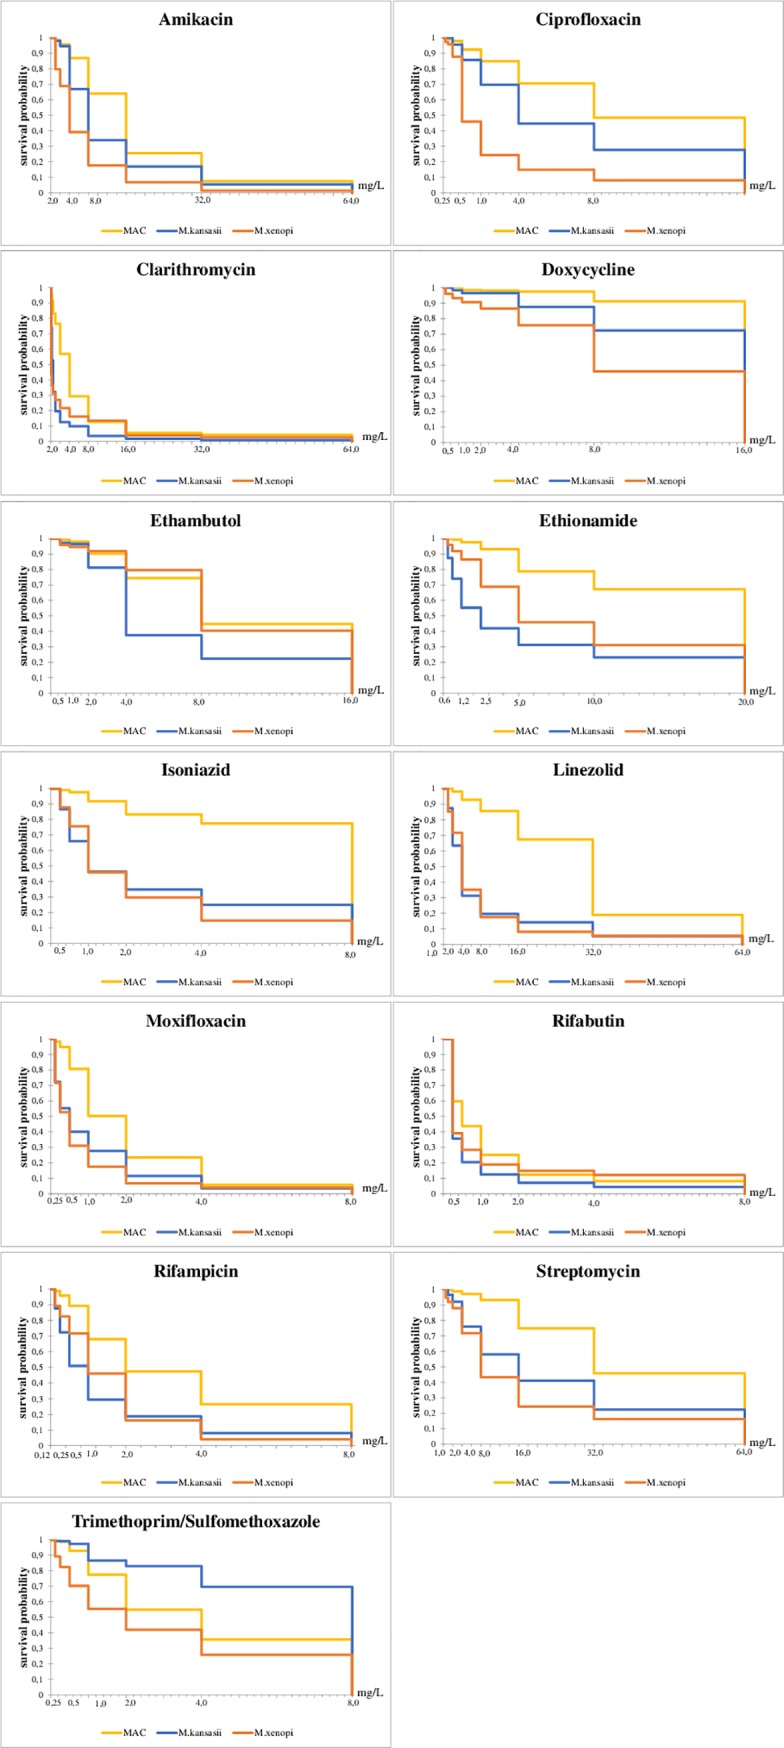
The comparison of Kaplan-Meier survival curves for MICs of drugs used against NTM.